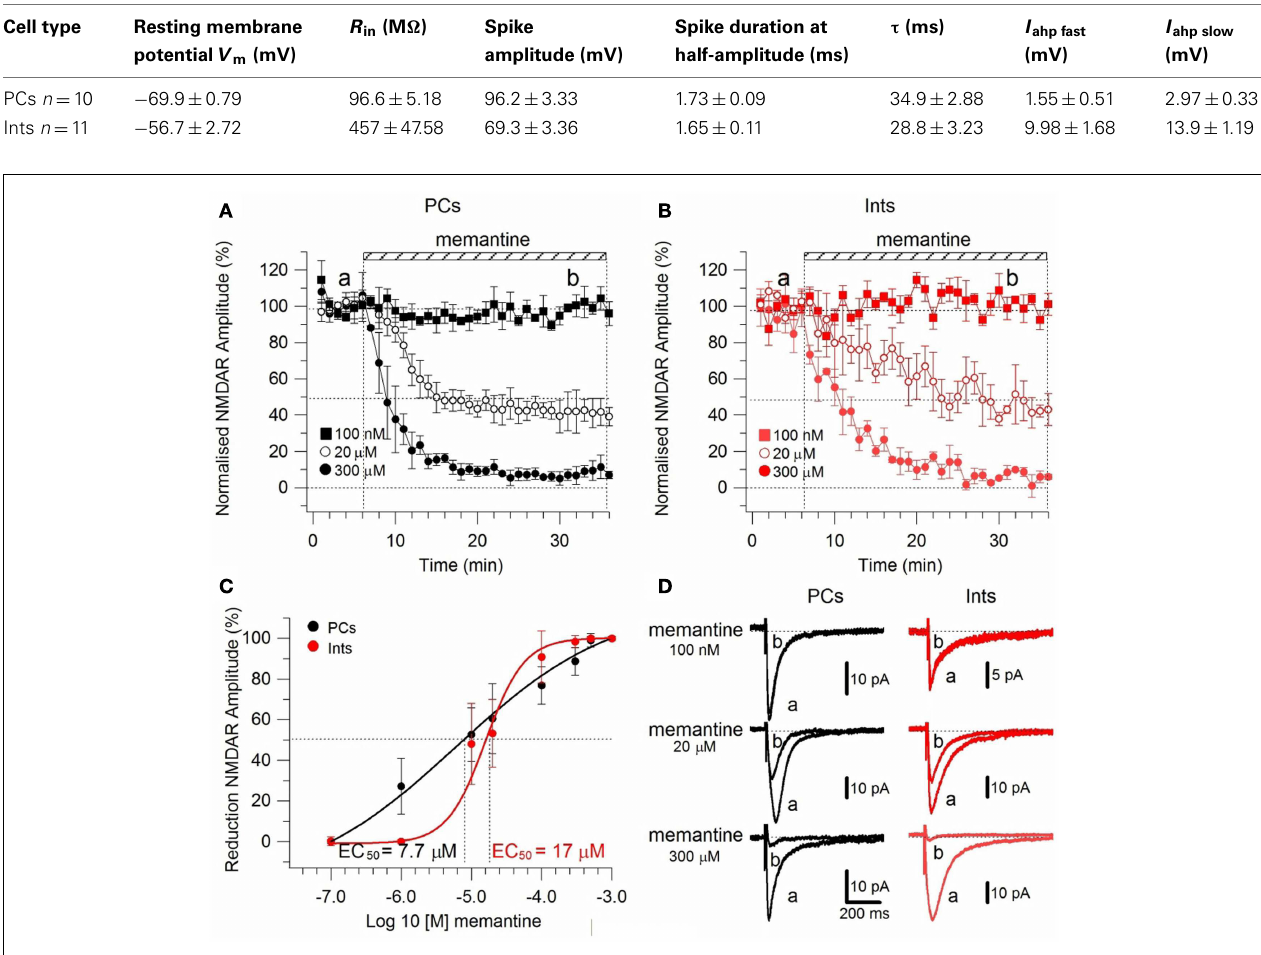
amplitude of NMDAR currents by 0% ( n = 3), 0.5 ± 0.4% ( n = 7); 48.3 ± 4.98% ( n = 16), 53.22 ± 8.35% ( n = 5), 90.85 ± 6.4% ( n = 4), 98.29 ± 1.7% ( n = 3), and 100% ( n = 3), respectively. Normalized NMDAR current amplitudes (%) are plotted as a function of time for memantine concentrations of 100nM (full square), 20 µ M (empty circle), 300 µ M (full circle). Each point (one every min) is the average of six points (stimulations every 10s).The bars indicate the duration of memantine exposure. Mean ± sem. (C) Memantine dose-response curve in PCs (black) and Ints (red), respectively. Error bars represent SD. (D) Examples of traces of NMDAR currents measured before (a) and after memantine applications (b) are shown for PCs (black) and Ints